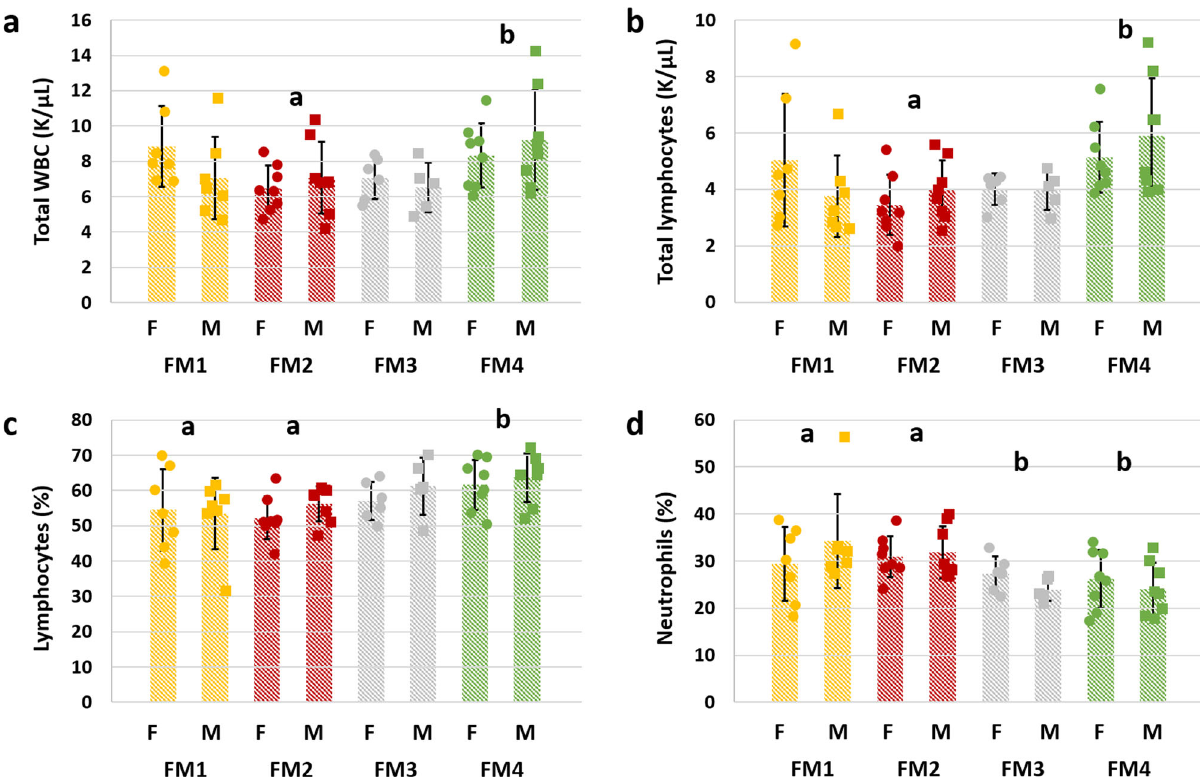
Fig. 6 Supplier-dependent FMs are associated with differences in peripheral leukocyte populations. Dot plots showing a total white blood cell (WBC) count (K/ µ L) ( p = 0.016, F = 3.77), b total lymphocyte count (K/ µ L) ( p = 0.007, F = 4.6), c percent lymphocytes ( p = 0.012, F = 4.0), and d percent neutrophils ( p = 0.006, F = 4.7) in peripheral blood of female (F) and male (M) CD-1 mice colonized with one of four supplier-origin gut microbiomes (legend at bottom). p and F values represent the main effects of FM in two-way ANOVA, and post hoc comparisons via Holm – Sidak method; signi fi cant FM-dependent differences are denoted by different letters, n = 8/sex/FM at all time-points, underlying bar charts represent mean ± region, fl anked by Illumina standard adapter sequences 55,56 . Oligonucleotide DNA was eluted in 100 µL buffer and quanti fi ed using Quanti-iT BR dsDNA kits and Qubit 2.0 fl uorometer (Thermo Fisher). sequences are available at proBase 57 . Dual-indexed forward and reverse primers were used in all reactions. PCR was performed in 50µL reactions containing 100 ng metagenomic DNA, primers (0.2 µM each), dNTPs (200 µM each), and Phusion high- fi delity DNA polymerase (1U). Ampli fi cation parameters were 98°C (3:00) + [98 °C (0:15) + 50 °C (0:30) + 72 °C (0:30) ]×25 cycles + 72 °C (7:00) . Amplicon pools (5 µL/reaction) were combined, thoroughly mixed, and then puri fi ed by addition of amplicons were constructed via ampli fi cation of the V4 region of the 16S rRNA Axygen Axyprep MagPCR clean-up beads to an equal volume of 50 µL of gene with universal primers (U515F/806R) previously developed against the V4